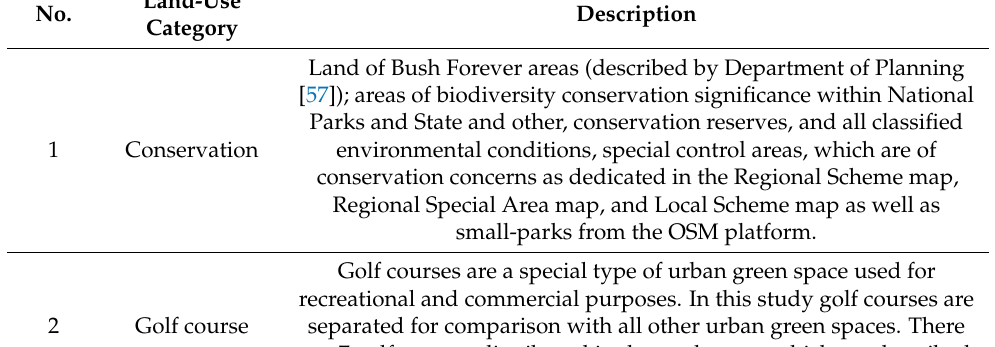
Table 3. Description of land-use